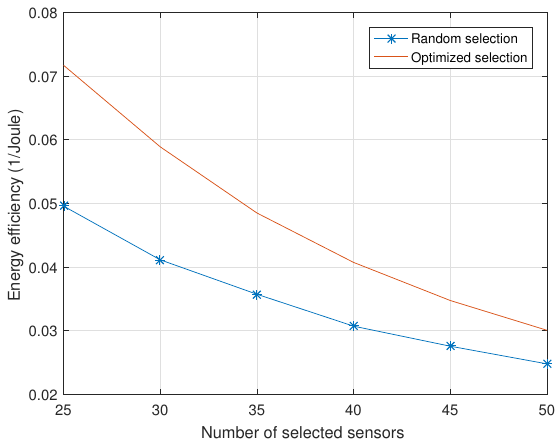
Figure 5. Energy efficiency versus different number of selected sensor